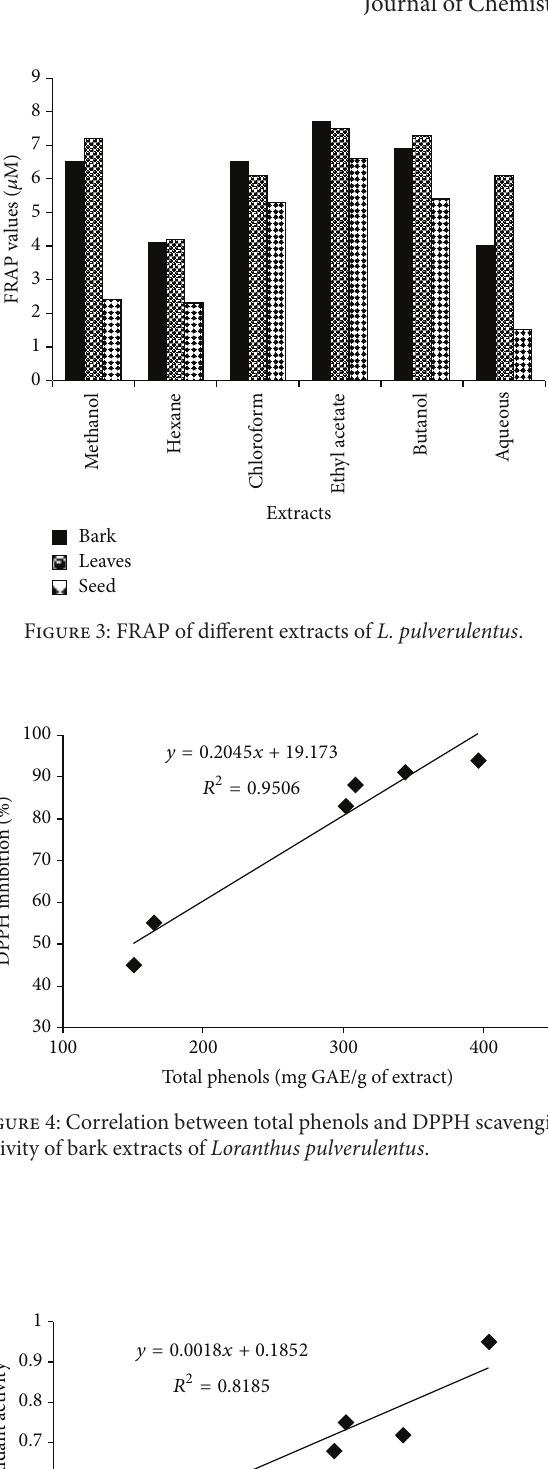
y = 0.0018x + 0.1852 R 2 = 0.8185